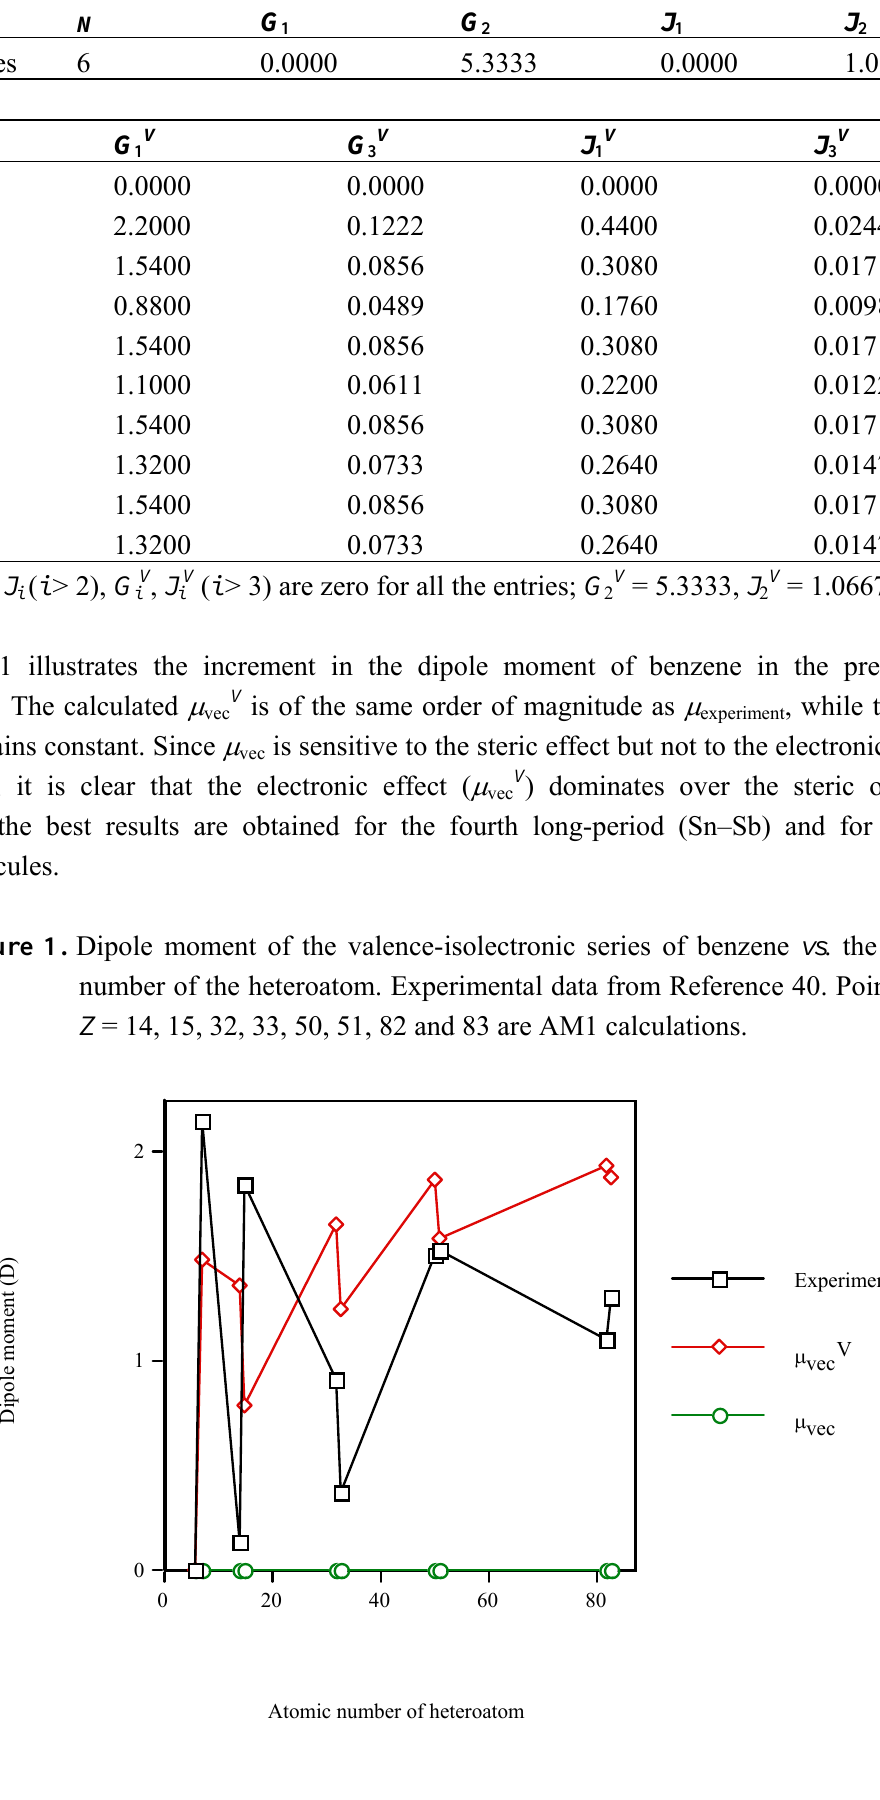
Table 2. Charge indices up to the fifth order for the valence-isoelectronic series of benzene. a